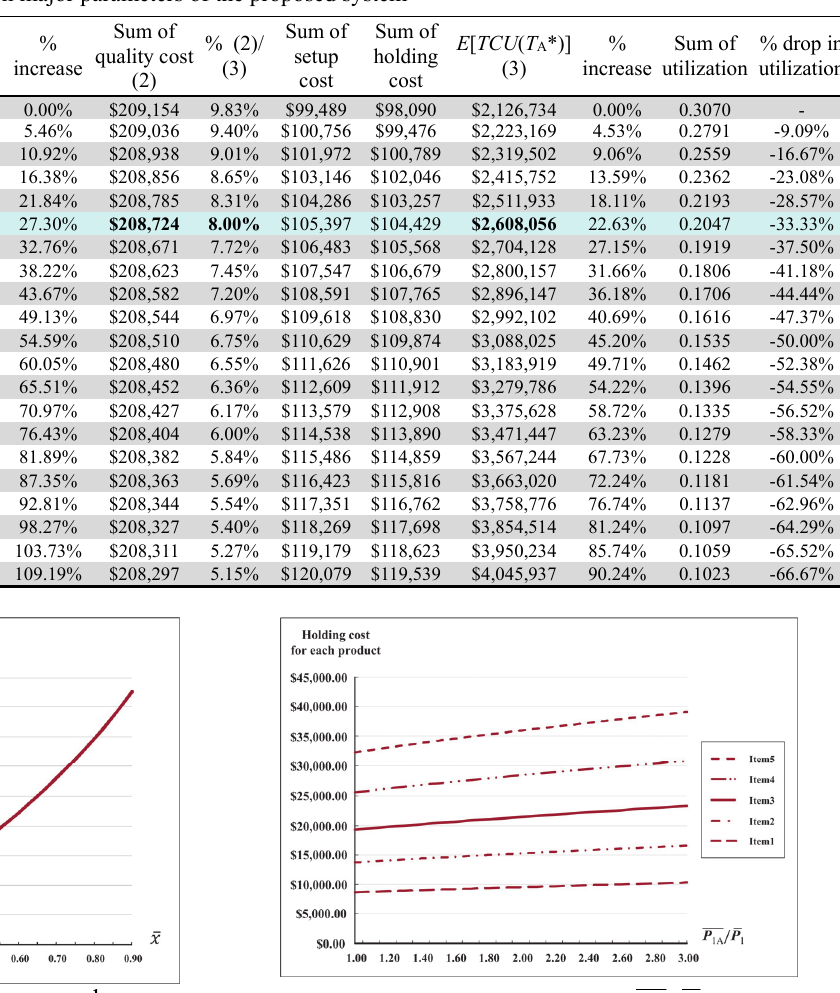
P / P on the 1A 1